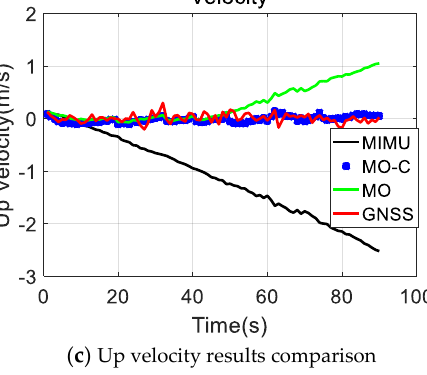
Figure 6. Velocity results comparison.